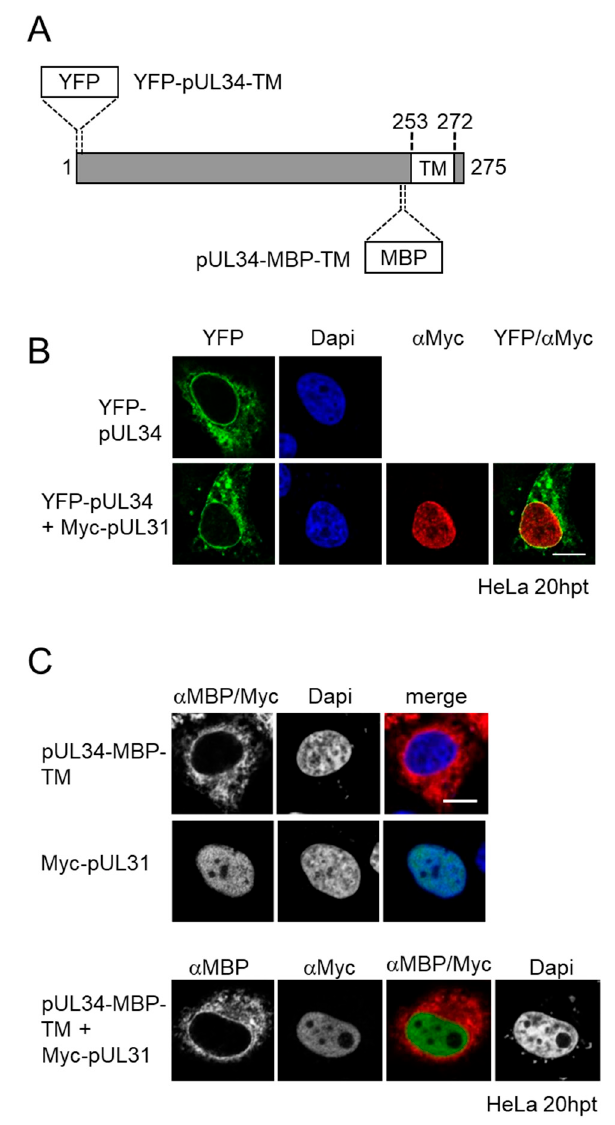
Figure 1. Membrane insertion of pUL34 occurs prior to its nuclear import. ( A ) Schematic depiction of the TA membrane protein pUL34 with the C-terminal transmembrane domain (TM) and either the N-terminal YFP tag (YFP-pUL34-TM) or a pre-TM-inserted MBP-tag (pUL34-MBP-TM); ( B , C ) HeLa cells were transfected with plasmids encoding YFP-pUL34-TM, pUL34-MBP-TM or Myc-pUL31 either alone (( B , C ) top panels) or in combinations (( B , C ), bottom panels). pUL31 localization was determined by using anti-Myc antibodies, while pUL34-MBP-TM was detected by anti-MBP antibodies followed by secondary reagents. YFP-tagged pUL34 was visualized directly using confocal microscopy. Nuclei were visualized by Dapi. The scale bar corresponds to 10 µm.